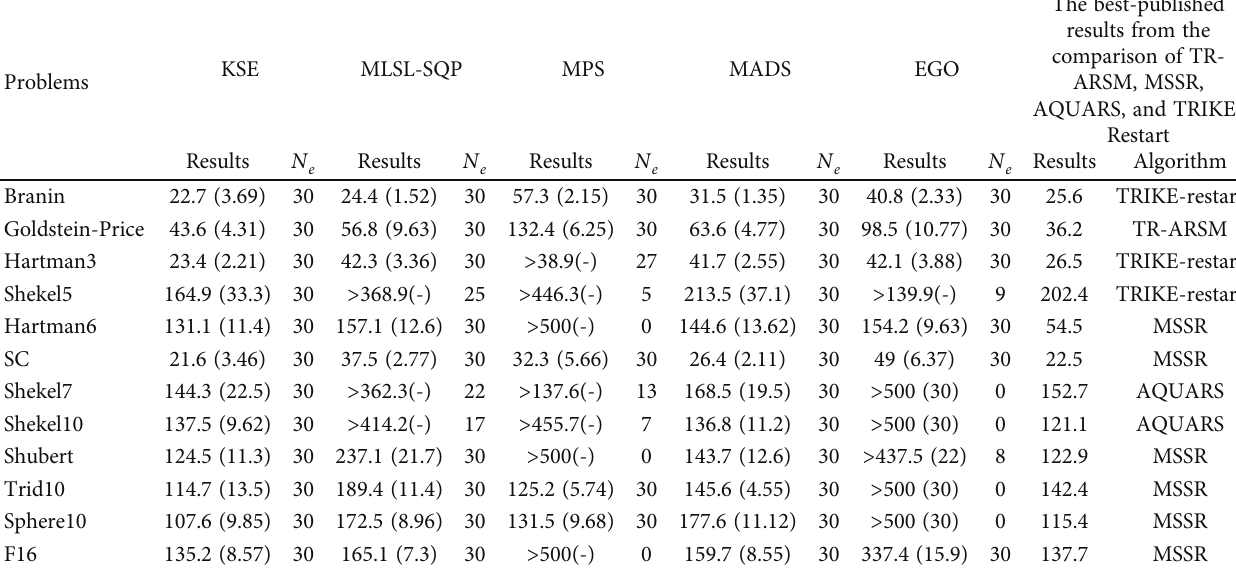
Table 3: Average number of function evaluations (over 30 trials) to get a relative error of < 1%.